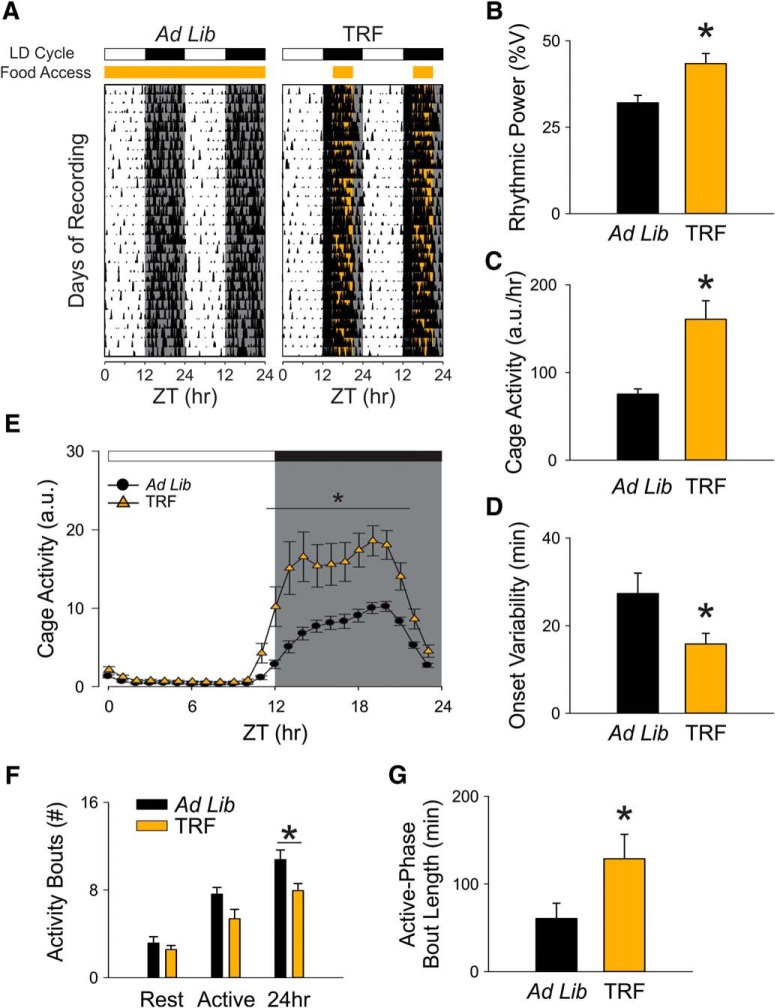
Locomotor activity rhythms were improved by the TRF regimen. A, Examples of cage activity rhythms recorded from Q175 mutants under control (left) and TRF (right) conditions. The activity levels in the actograms were
normalized to the same scale (85% of the maximum of the most active individual). Each row represents two consecutive days, and the second day is repeated at the beginning of the next row. The orange bar on the top of actograms indicates the time when food hopper is opened. B, The strength of the activity rhythm is indicated by the power (%V) of the χ2 periodogram analysis. C, The averaged level of cage activity. D, The averaged variation in onset from the best-fit regression line. E, Average waveforms from 10 d of cage activity (1-h window) are shown and SEs across animals are indicated. F, The number of activity bouts (separated by a gap of 21 mins or more) during rest phase (ZT 0-12), active phase (ZT 12-24), and 24 h are reported as the level of fragmentation of the circadian activity cycle. Black bars represent Q175 mutants under ad lib condition, and orange bars represent Q175 mutants under timed feeding condition. G, The average length of activity bouts during their active phase. The white/black bar on the top of actograms (A) and waveforms (E) indicates the 12/12 h LD cycle. The temporal activity wave form was analyzed using a two-way RM ANOVA with time and treatment as factors. Other comparisons between Q175 cohorts were made using a t test. Asterisks represent significant differences due to TRF regimen compared to ad lib controls (p < 0.05); n = 8/group.